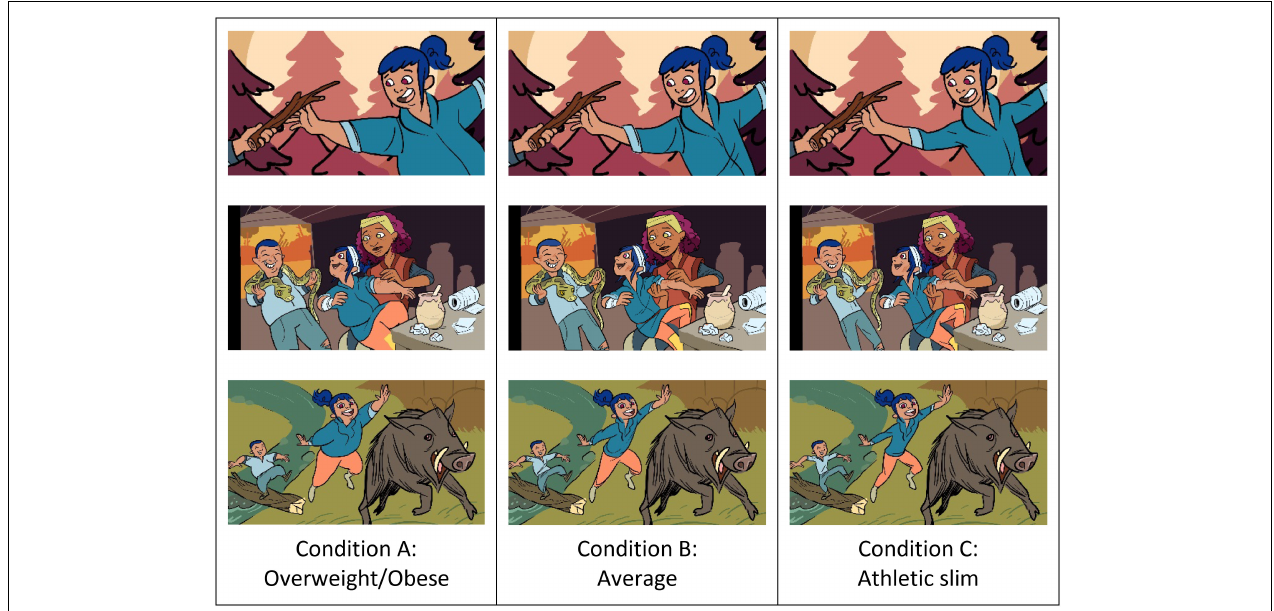
FIGURE 1 | Image stills taken from the narrative trailer for each of the three body shape conditions. Produced by FableVision Studios for Northeastern University. Reproduced with permission from Northeastern